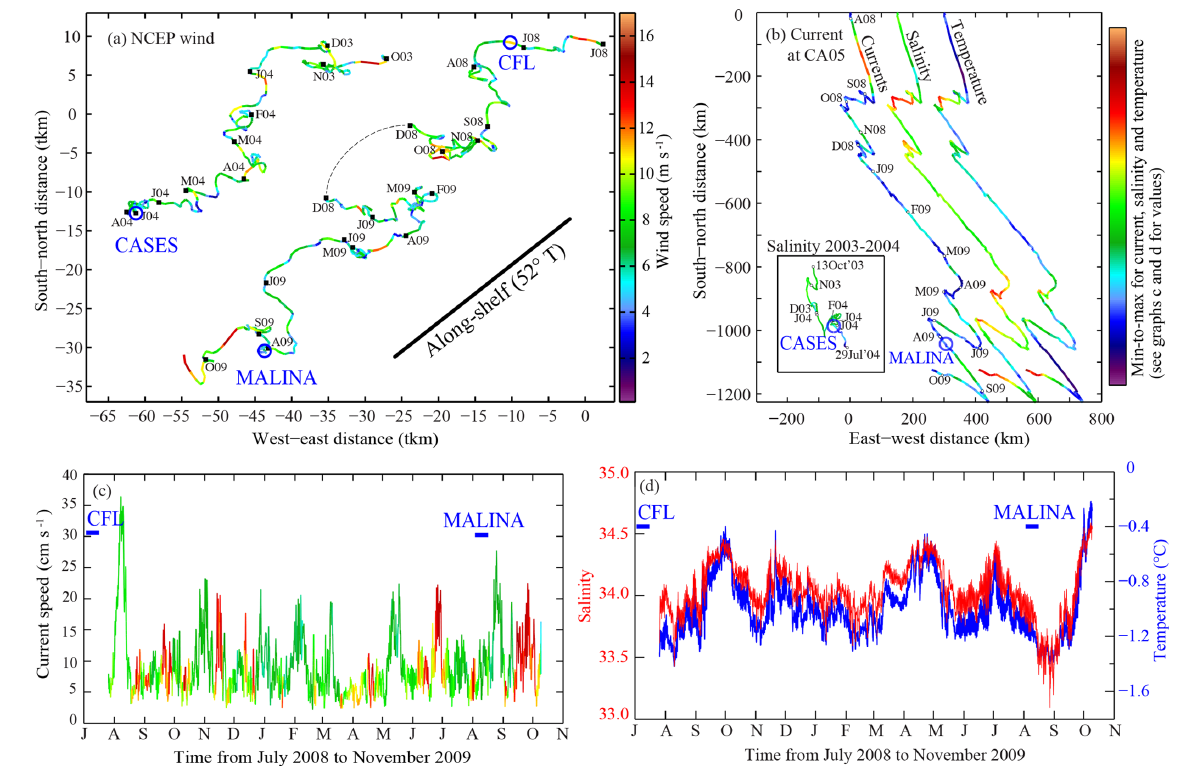
Figure 11. Progressive vector plots of (a) daily average wind (NCEP, 10m) and (b) currents from mooring CA05, with am inset for 2003– 2004 CASES data. Colors in (a) indicate daily average wind speeds shown in the color bar. The black squares in (a) and (b) indicate the start of each month (the first letter of month followed by year, e.g., D03 stands for December 2003), while the blue circles show the approximate times of the ship-based transect sampling across the Mackenzie Shelf break used in this study. The black line shows the direction along the shelf break referenced to true north. In (b) , the same vector plot for currents is shown three times, but the colors of each plot indicate current speed, salinity, or temperature as denoted next to the lines and shown in more detail in (c) and (d) . For the inset in (b) showing 2003–2004, the colors indicate salinity as denoted. Time series for 2008–2009 for (c) current speed (colors are current directions), (d) salinity (red), and temperature (blue) at a depth of